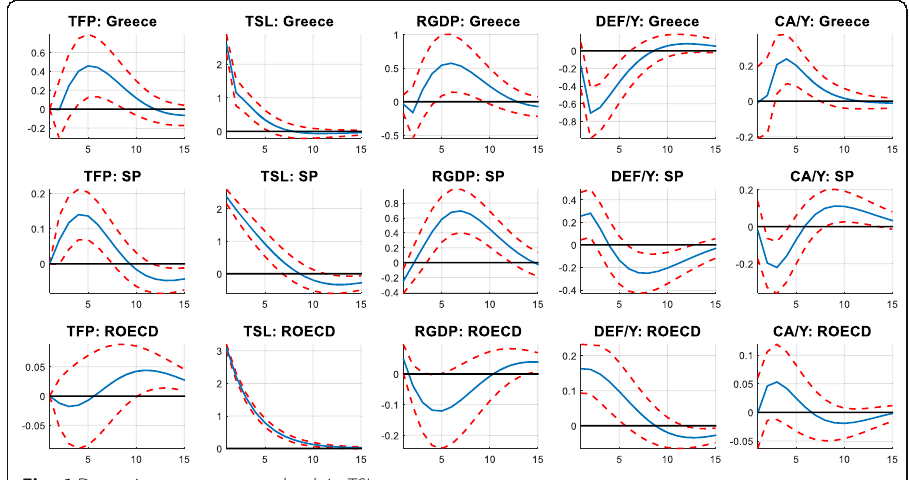
Fig. 6 Dynamic responses to a shock in